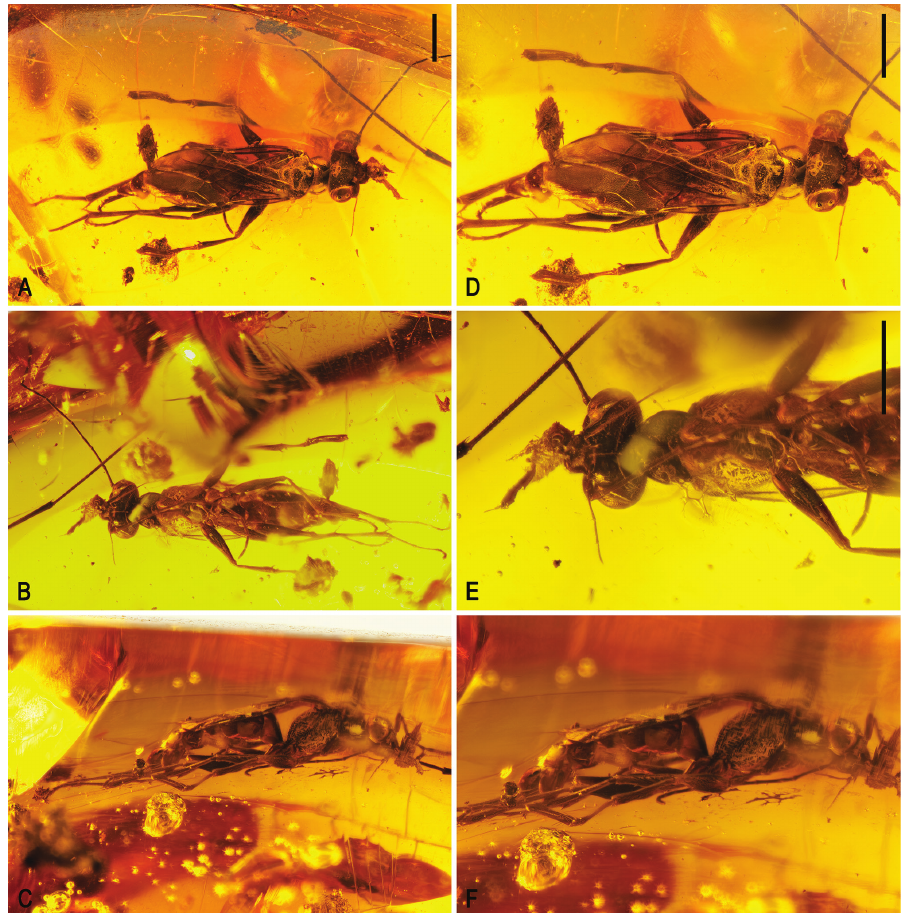
Figure 2. † Thaumatodryinus miocenicus Olmi, 1995, female holotype. A habitus, dorsal view B habitus, ventral view C habitus, lateral view D habitus, dorsal view E head and mesosoma, ventral view F habitus, lateral view. Scale bars: 1 mm ( A–C ), 1 mm ( D, F ), 1 mm ( E